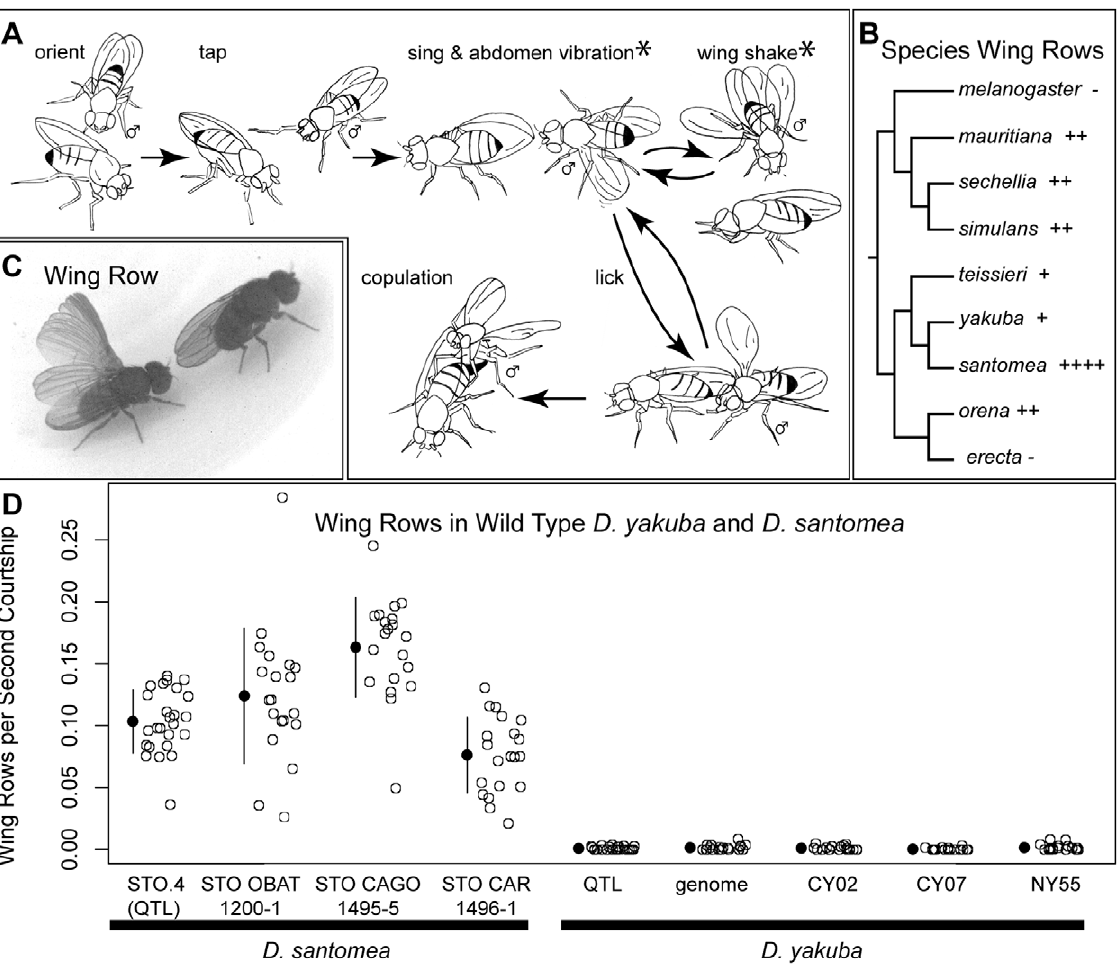
Figure 1. Courtship behavior in wild type D.yakuba and D.santomea . (A) Males of both species first orient towards the female and tap her with a T1 leg. Then they approach the back or the side of the female and periodically sing by vibrating one extended wing. Song bouts are punctuated by circling to the side and front of the female (circling is sometimes accompanied by shaking of both wings) or by attempts to lick the female’s genitalia. If the female is receptive, a lick is followed immediately by copulation. Cartoons were adapted from movie still images. Courtship steps at which D. santomea males are observed to row are marked with an asterisk (*). (B) Distribution of wing rowing in the species of the D. melanogaster species subgroup. The molecular phylogeny was adapted from Prud’homme et al. [55]. ( 2 ) and ( + ) indicate which species row, and relative rowing frequencies (rows/second courtship): D. mauritiana =0.0322; D. sechellia =0.0228; D. simulans =0.0279; D. teissieri =0.0061; D. yakuba =0.0010; D. santomea =0.1033; D. orena =0.0144. (C) Chronophotograph of a D. santomea male rowing while positioned behind a stationary female. (D) The frequency of rowing in multiple independent D. santomea and D. yakuba isolates. y-axis: wing rows normalized to seconds of courtship in a 15 minute movie. Sample means are marked by the filled circle and lines indicate + / 2 one standard deviation. Species level differences D. santomea and D. yakuba lines were highly significant (Nested Anova; D.F.=4,184; F=266.4; p , 2.2e-16), while only D. santomea STO CAGO 1495-5 rowed significantly more than the other D. santomea isolates (Anova; D.F.=3, 81; F=18.26; p , 1.62e-06) and there were no significant differences between D. yakuba isolates.